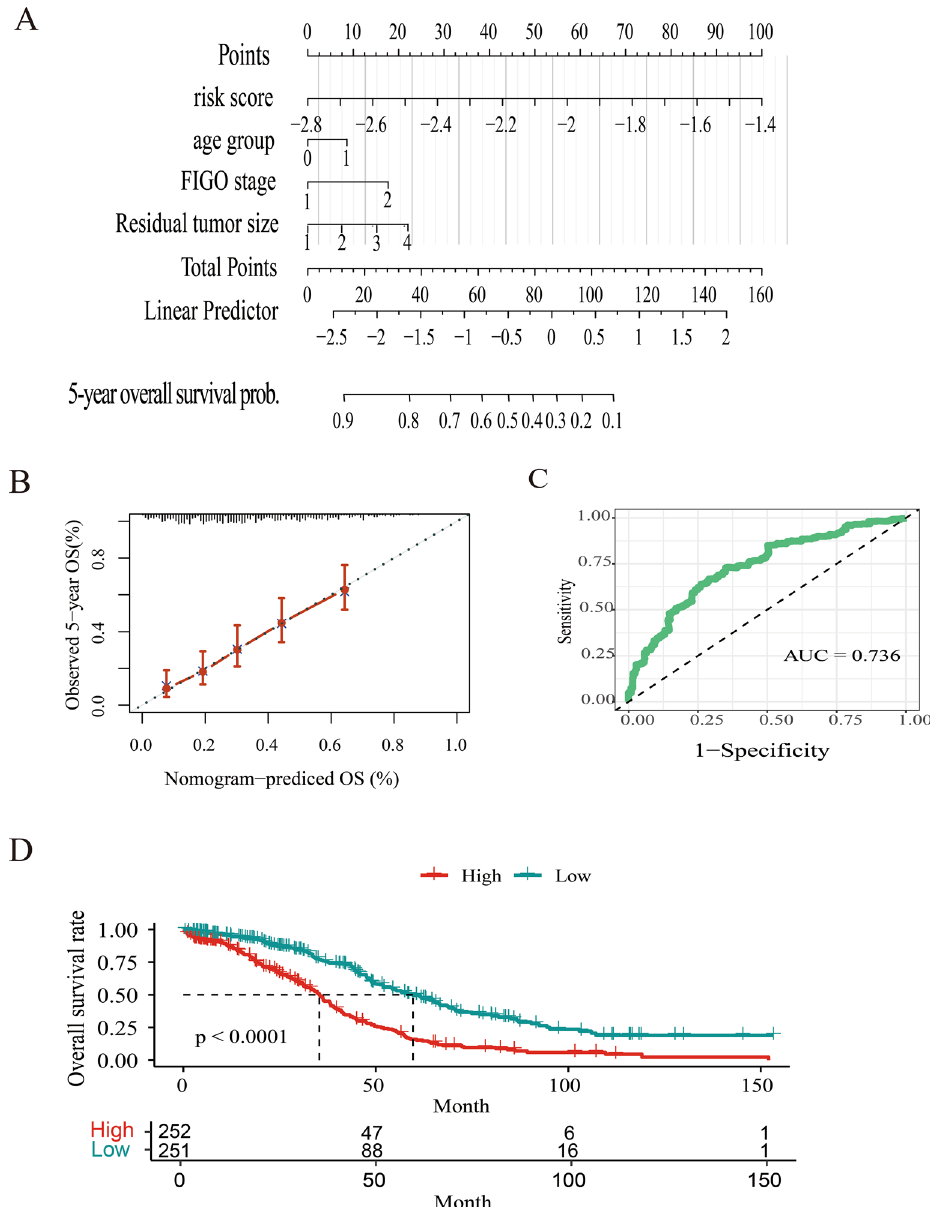
Figure 9. Prognostic nomogram for predicting the 5-year overall survival of SOC patients. ( A ) Prognostic nomogram for glioma patients was created based on clinical risk factors; For age group, 0 means < 50 years old and 1 means > 50 years old. For FIGO stage, 1 means FIGO I + II and 2 means FIGO III + IV. For residual tumor size, 1 means residual tumor size < 1 mm; 2 means 1 mm < residual tumor size < 10 mm; 3 means 10 mm < residual tumor size < 20 mm and 4 means residual tumor size > 20 mm. ( B ) The calibration curve of 5-year overall survival. The predicted probability of overall survival is plotted on the x-axis and the observed OS is plotted on the y-axis; ( C ) ROC curve from the nomogram of 5-year overall survival; ( D ) Comparison of overall survival between two groups divided by the median value of the prognostic model (Low vs.